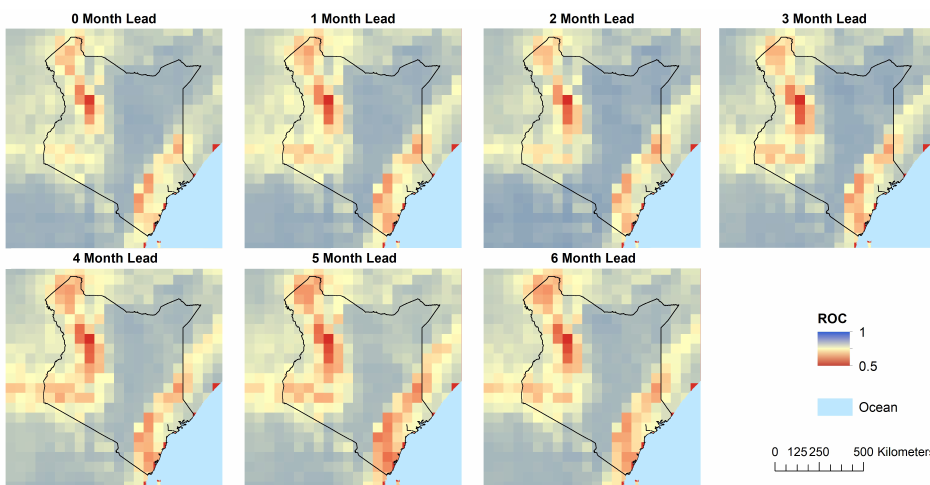
Figure 5. Probability of detection for wet anomaly events.